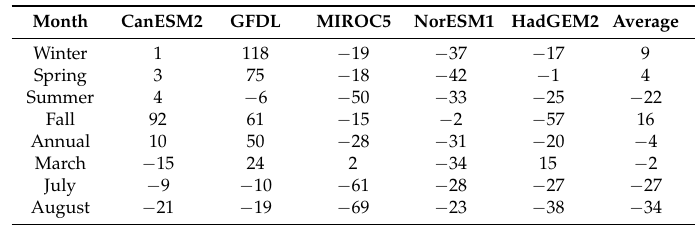
Table 4. Projected changes (%) in precipitation under RCP8.5 of different GCMs in the 2050s with respect to 1971–2000, in the Jhelum River